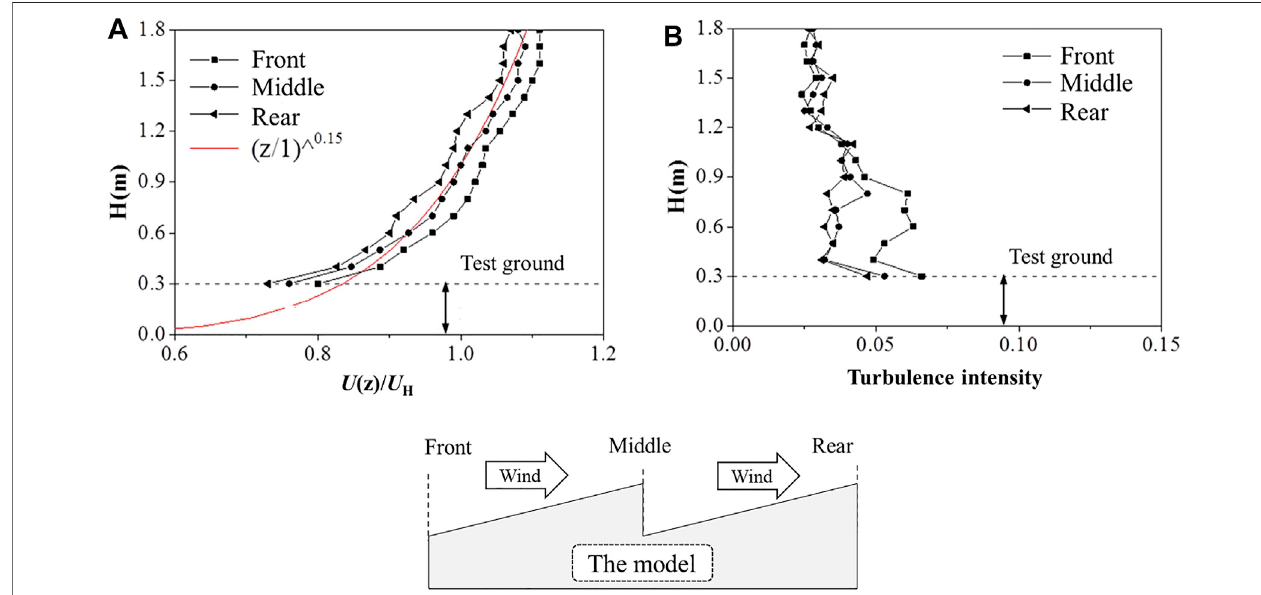
FIGURE 2 | Normalized mean wind speed (A) and turbulence intensity pro fi les with height (B) .